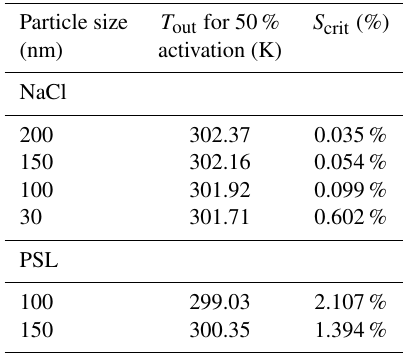
Figure 6. Activation curves as a function of T out (measured between the condenser tube and the virtual impactor) for NaCl particles of different sizes. Measured points fitted with sigmoidal curves. Table 3. Calculated critical supersaturations at the measured T out (at 50% activation) for NaCl and PSL particles of different